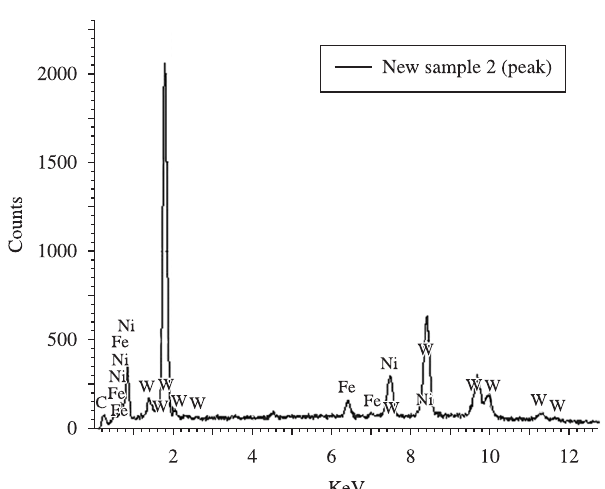
6.56 Figure 6. EDS analysis for powders milled for 8 hours.